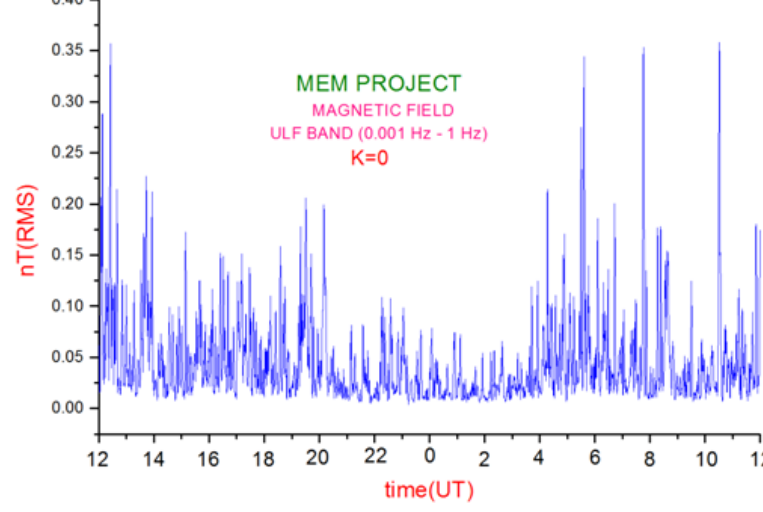
Figure 20. Diurnal variation of magnetic field noise, component Z adopted from Di Lorenzo et al.